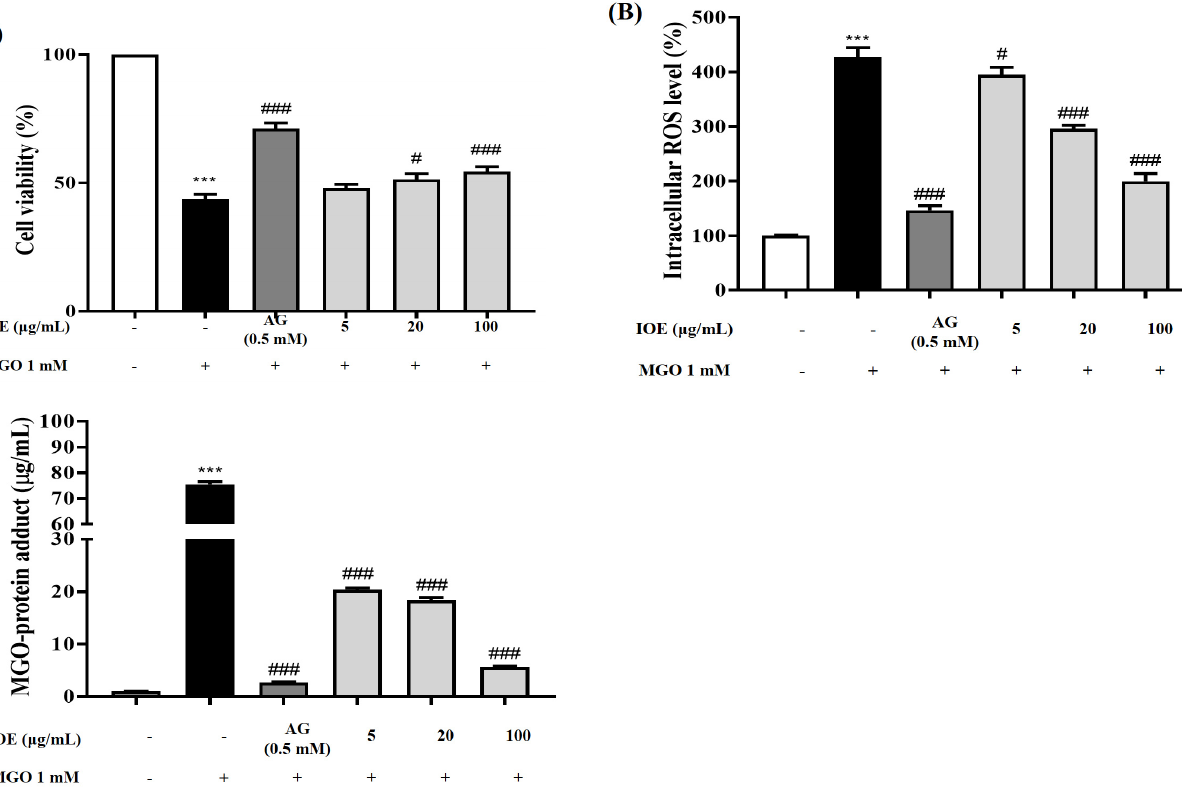
Figure 3. Protective effects of IOE on MGO-induced renal damage. Protective effect ( A ), intracellular antioxidant capacity ( B ) and MGO − cross − linked protein accumulation inhibitory effect ( C )of IOE on MGO − induced renal damage in mouse glomerular mesangial cells. A decrease in cell viability to lower than 80% compared to non − treated group was considered to be cytotoxic. Each experiment was performed three times independently. Bar values are presented as mean ± standard deviation ( n = 6). (*** p < 0.001 vs. normal group and # p < 0.05, ### p < 0.001 vs. MGO − treated group).